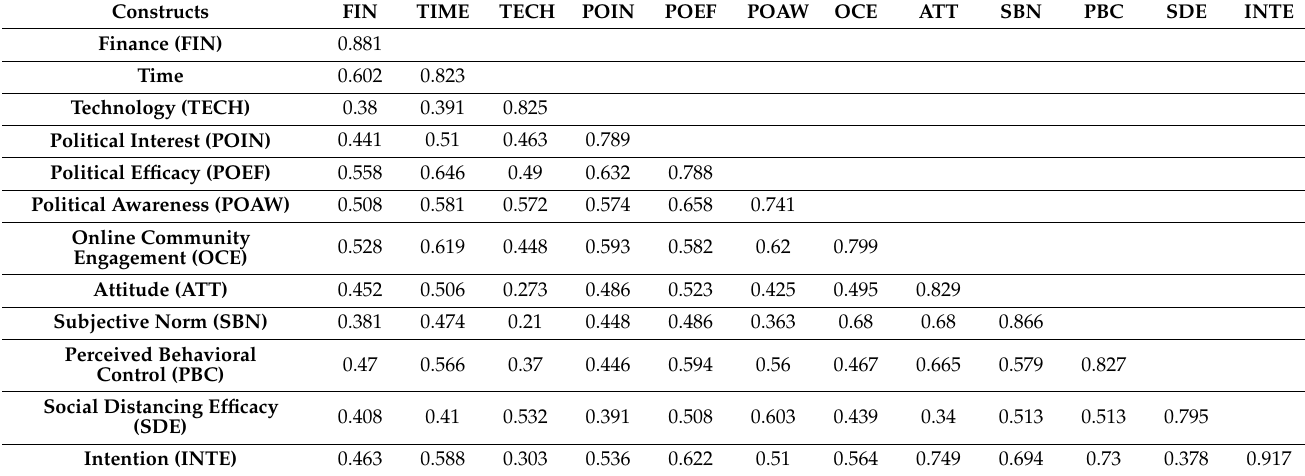
Table 2. Fornell–Larcker Criterion to assess discriminant validity.